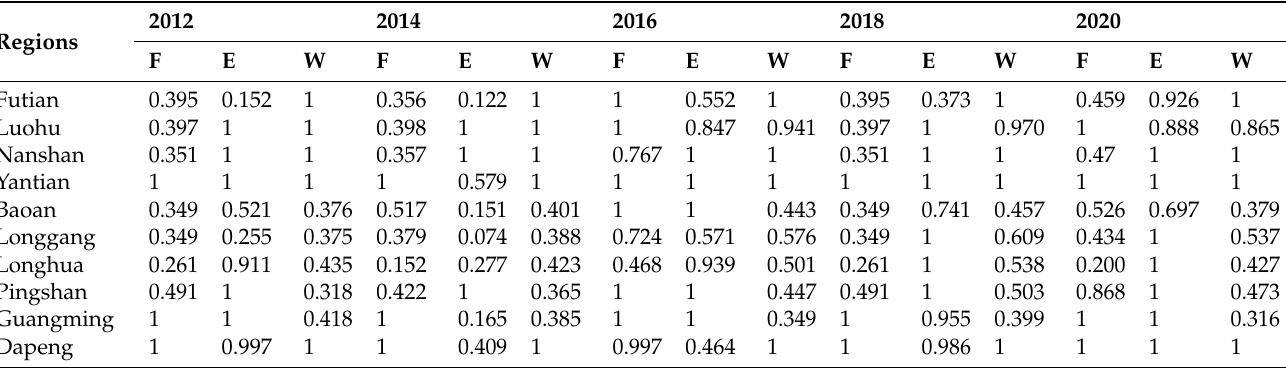
Table 3. Values for efficiency levels of interregional food, energy and water subsystems from 2012 to